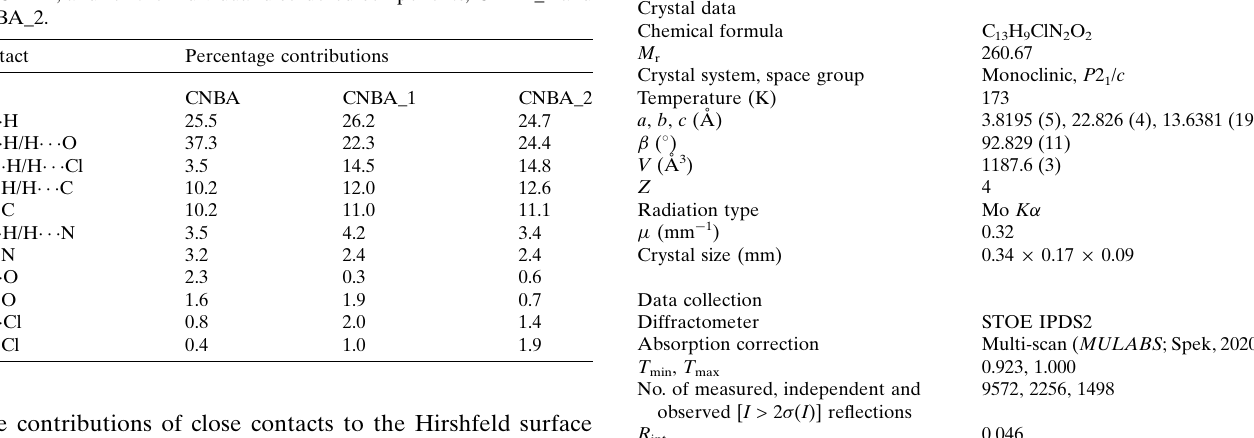
Table 3 Experimental details. Crystal data Chemical